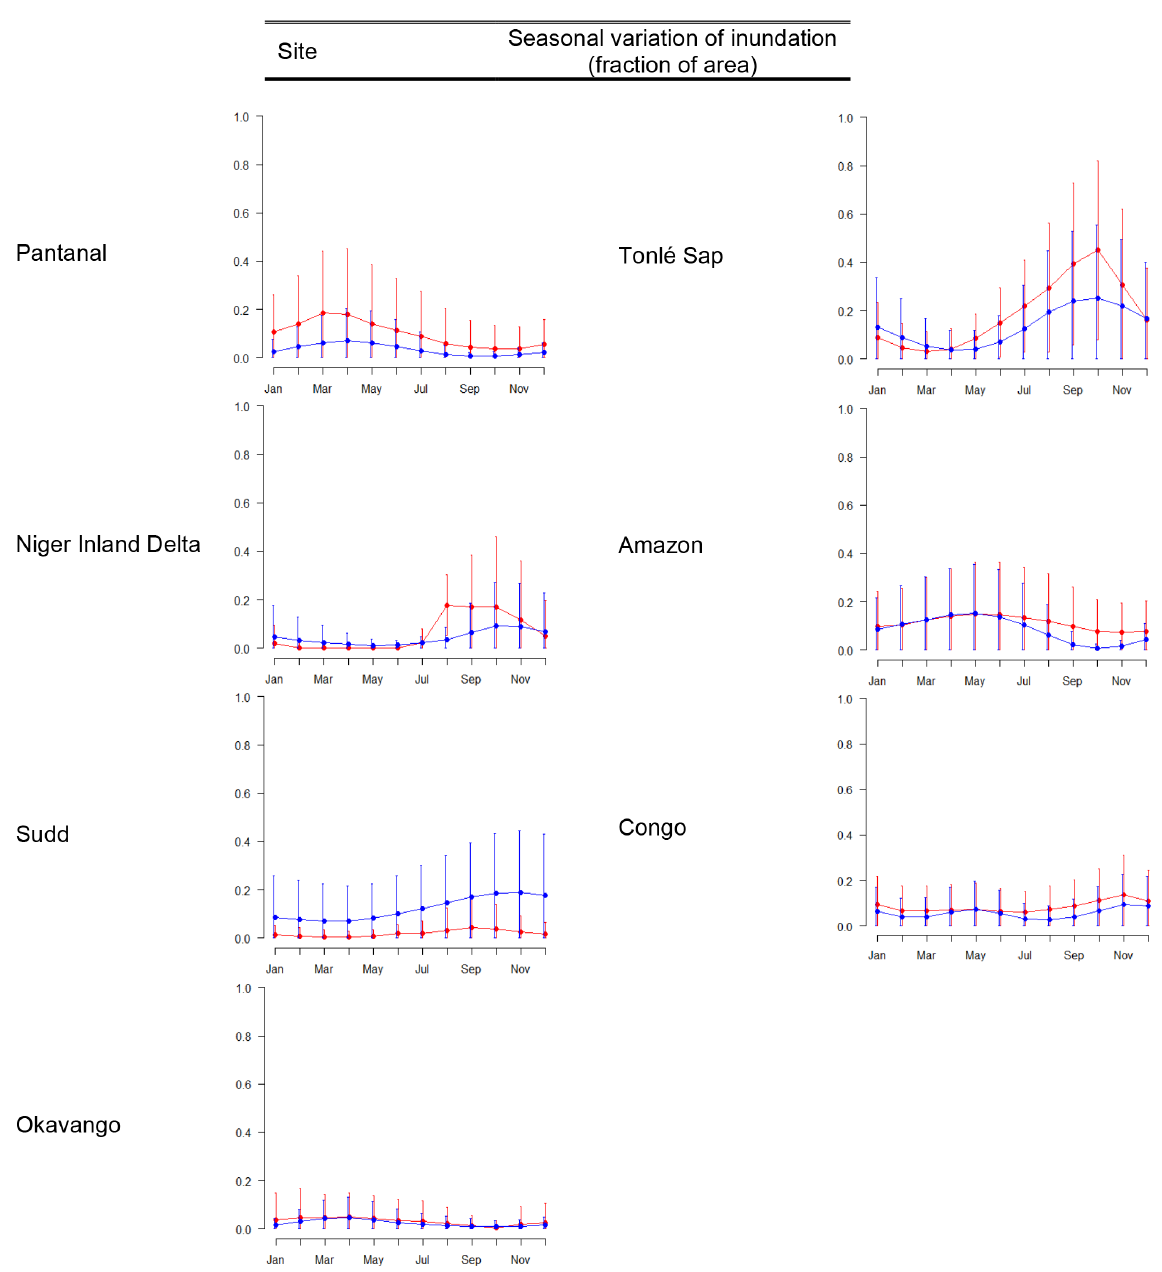
Figure 4. Seasonal variation in inundation across the study wetlands, averaged across the years 1992–2014: red: observations (GIEMS); blue: simulated (JULES-CaMa-Flood). The three main tropical zones are not shown because they include areas both north and south of the